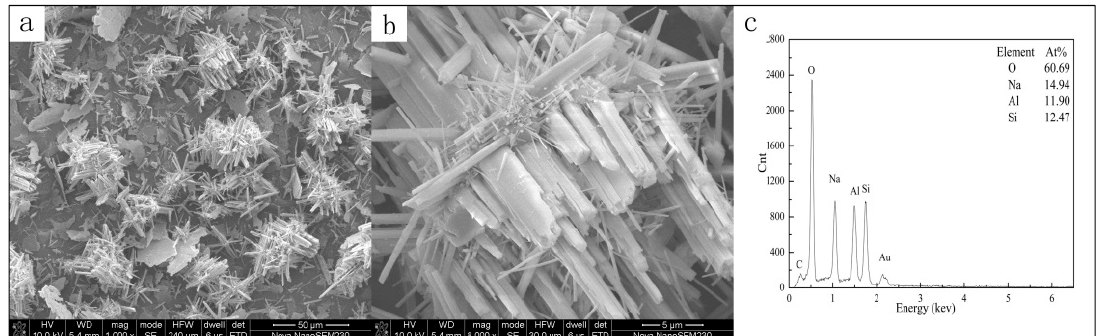
Figure 6. SEM-EDS analysis of alkali leached residue: ( a ) Magnification is 1000 times and scale bar is 50 μ m; ( b ) Magnification is 5000 times and scale bar is 10 μ m; ( c ) EDS (Experiment condition: alkali